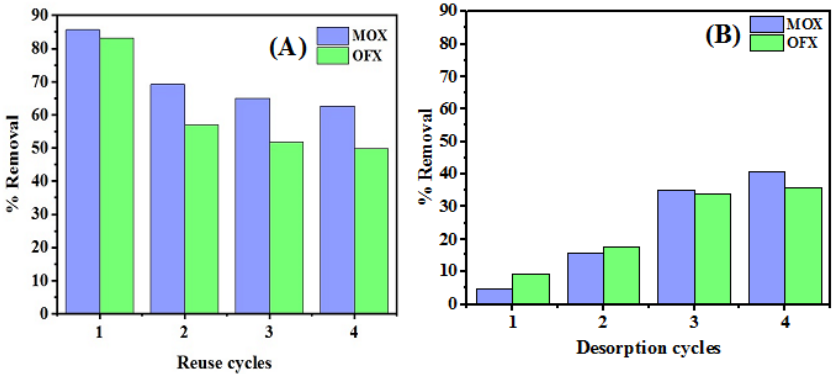
Figure 16. Performance of Met-GO/SA adsorbent through multiple regeneration cycles ( A ) and Desorption cycles ( B ).